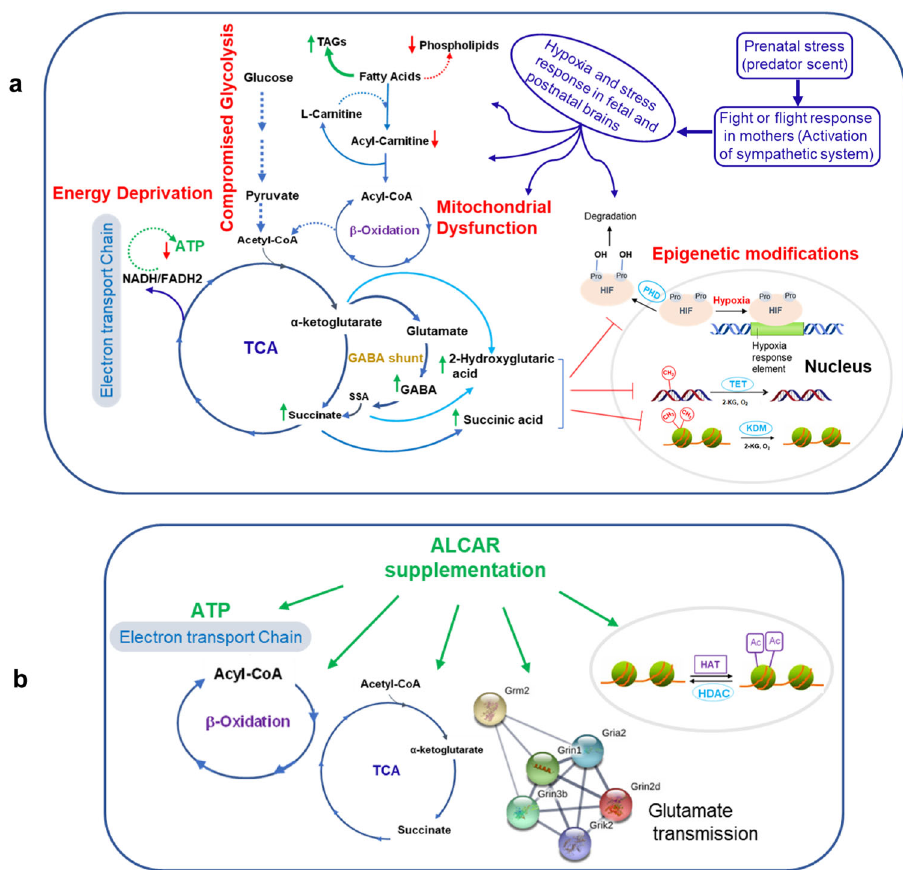
Fig. 7 Model. a Prenatal exposure to stress elicits depression through a number of mechanisms that may begin with hypoxia, which results in compromised glycolysis, energy deprivation, mitochondrial dysfunction (oxidative phosphorylation and ATP production), and altered epigenetic processes. b Possible mechanisms through which ALCAR may produce its antidepressant